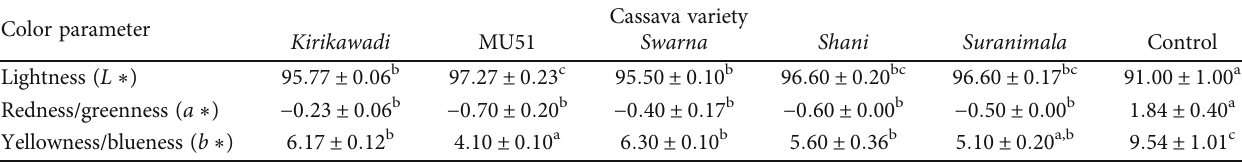
Values are expressed as mean ± standarddeviation of three independent determinations. Di ff erent superscripts in a row represent signi fi cantly di ff erent samples ( p < 0 : 05 ). Commercial wheat fl our was used as the control.